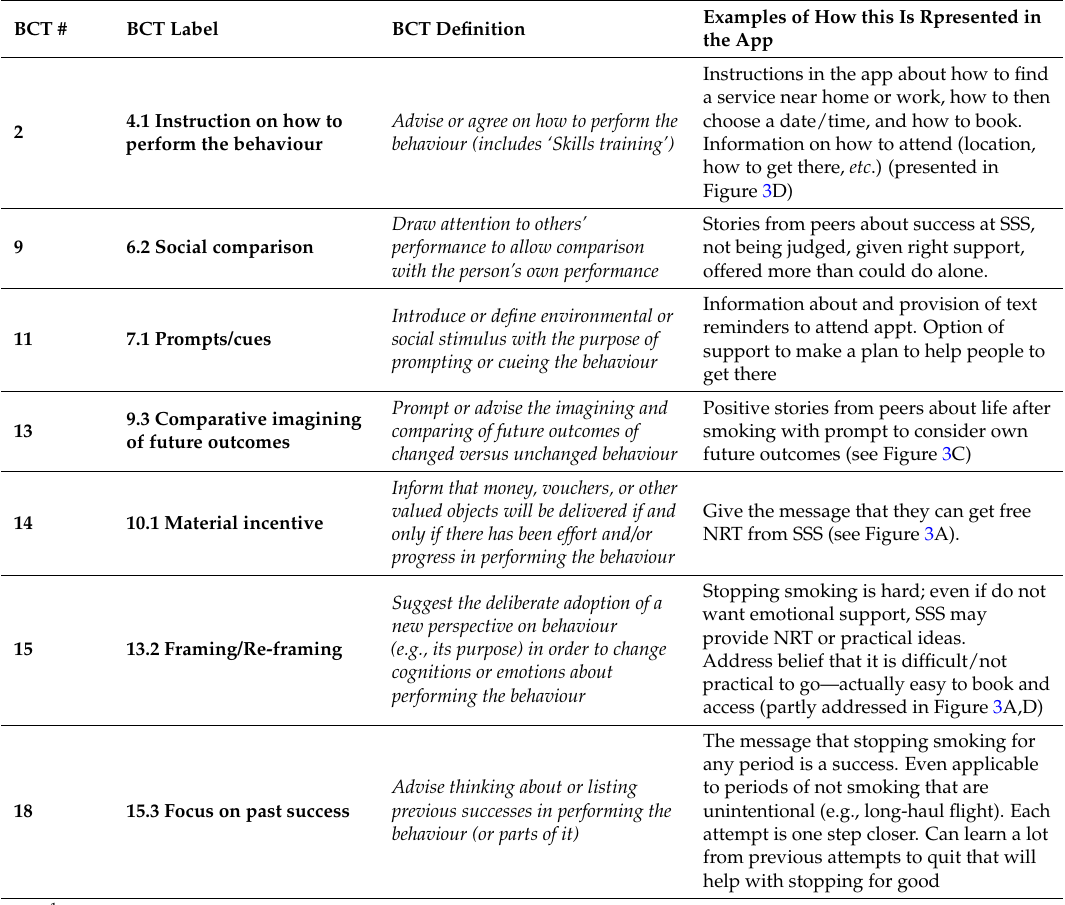
Table 3. Examples of some of the BCTs included in the StopApp and related detail about their content/representation, including reference to figures showing example prototype screenshots.